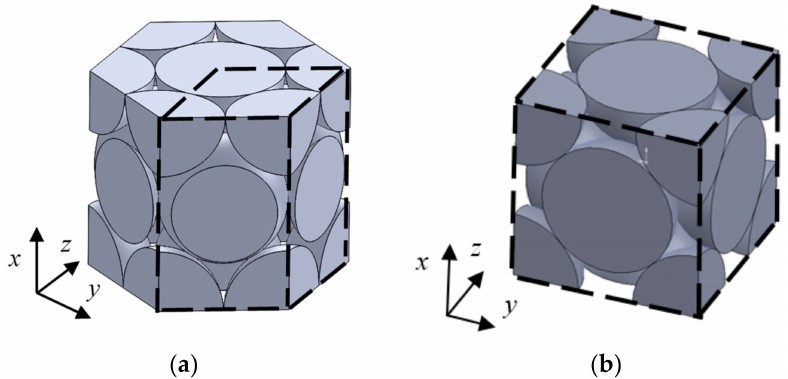
Figure 5. Analysis unit in each structure: ( a ) Hexagonal close-packed lattice; ( b ) Face-centered cubic lattice.